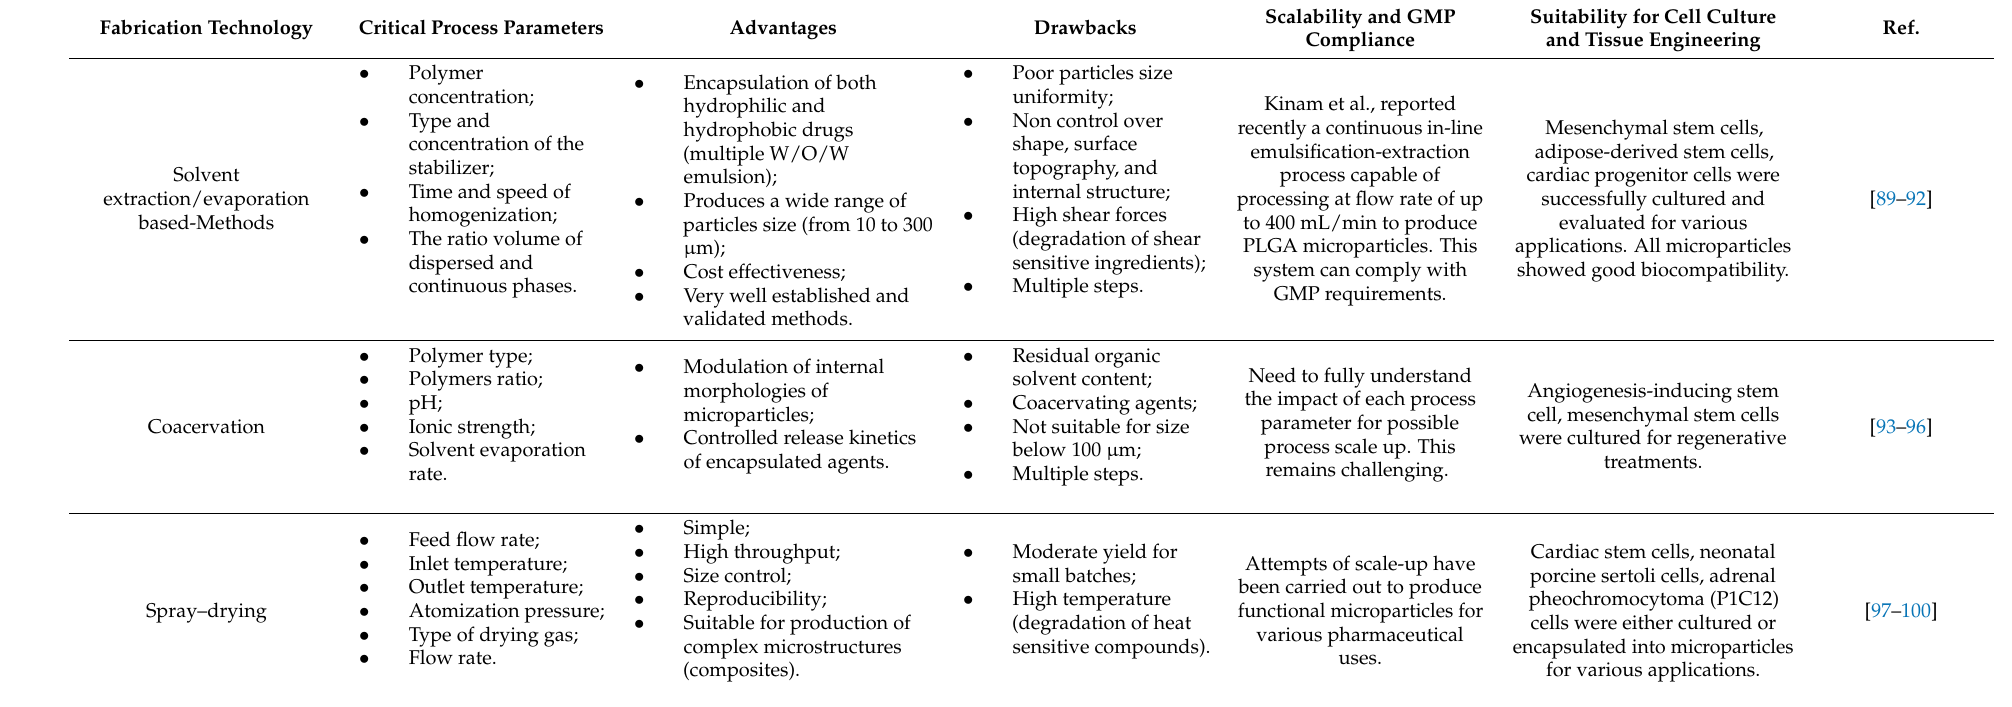
Table 2. Summary of the MPs fabrication